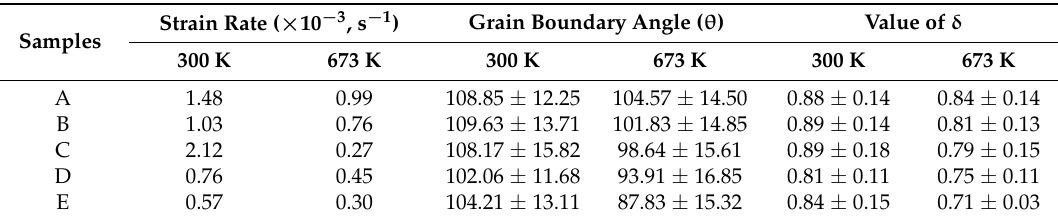
Table 2. Comparison of strain rates, grain boundary angles, and δ values measured from the five different alloys cast at 300 K and 673 K.